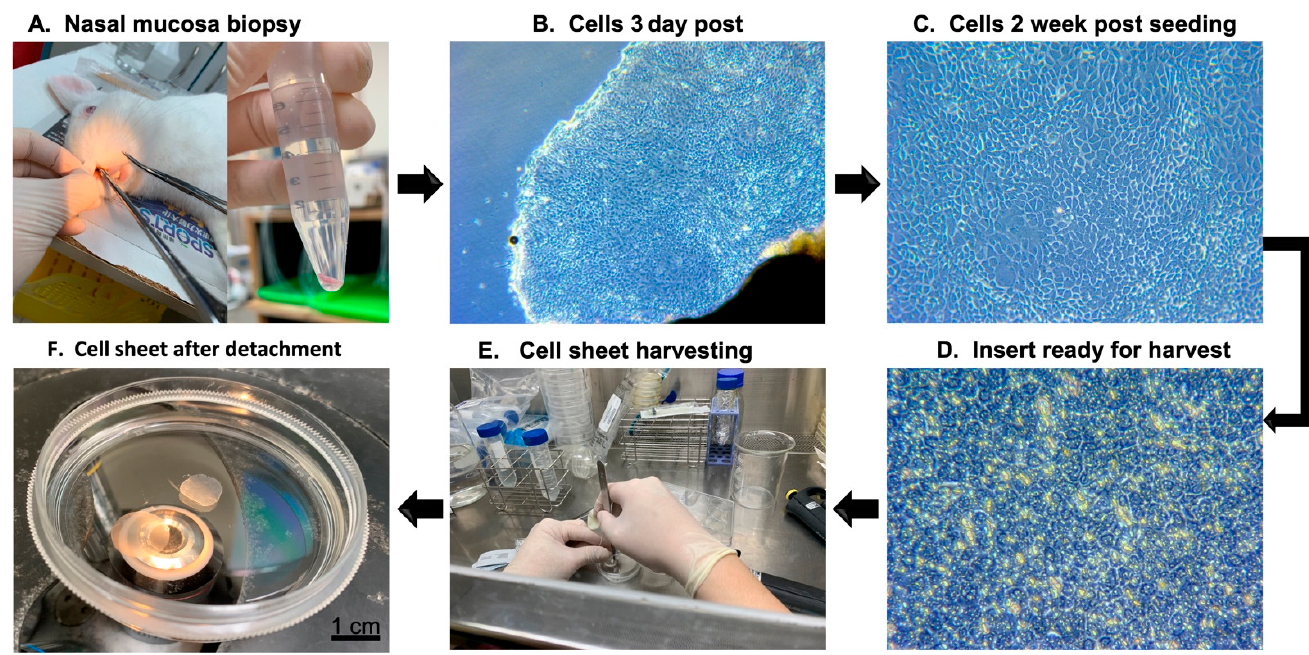
Figure 2. Flow diagram of the fabrication of the transplantable nasal epithelial cell sheets. ( A ): Nasal mucosa was harvested from the nasal cavity; ( B ): epithelial cells started to grow and move outside from the explanted tissue after 3 days of culture (magnification × 40); ( C ): nasal epithelial cells after 2 weeks of culture (magnification × 100); ( D ): cell sheet was ready for harvest after 10 days of seeding on culture insert (magnification × 200); ( E ): the cell sheet was detached from the insert membrane; ( F ): the harvested cell sheet had an intact and transplantable appearance.